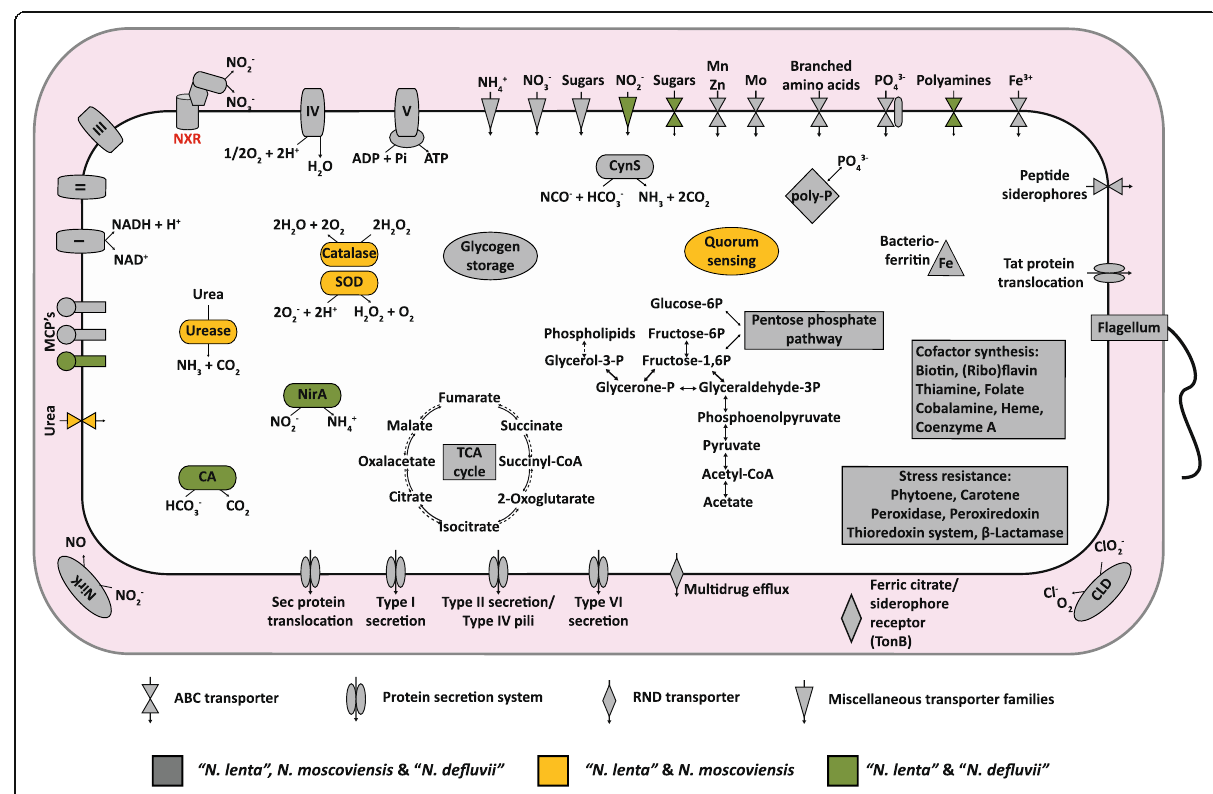
Fig. 5 Cell metabolic cartoon of “ N. lenta ” in comparison to N. moscoviensis and “ N. defluvii ” . CA, carbonic anhydrase; SOD, superoxide dismutase; CLD, chlorite dismutase; CynS, cyanate hydratase (cyanase); MCPs, methyl-accepting chemotaxis proteins; NirA, ferredoxin nitrite reductase; NirK, dissimilatory nitrite reductase. Enzyme complexes of the electron transport chain are labeled by Roman